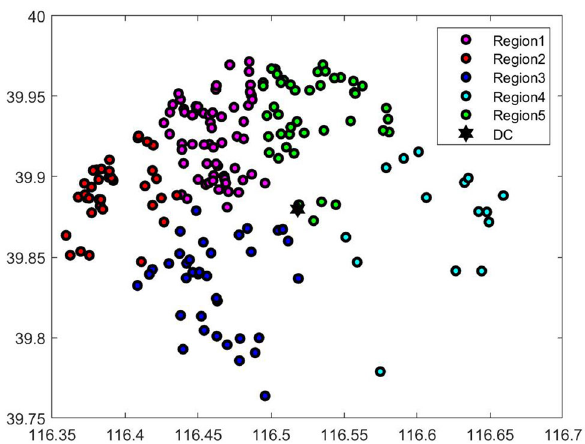
Fig. 5 Clustering region